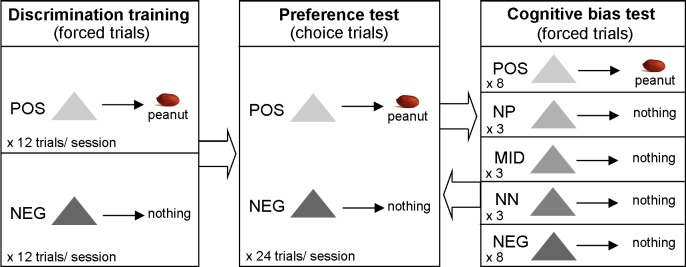
Methods summary.Diagram depicting the different types of trial in each phase of the experiment.